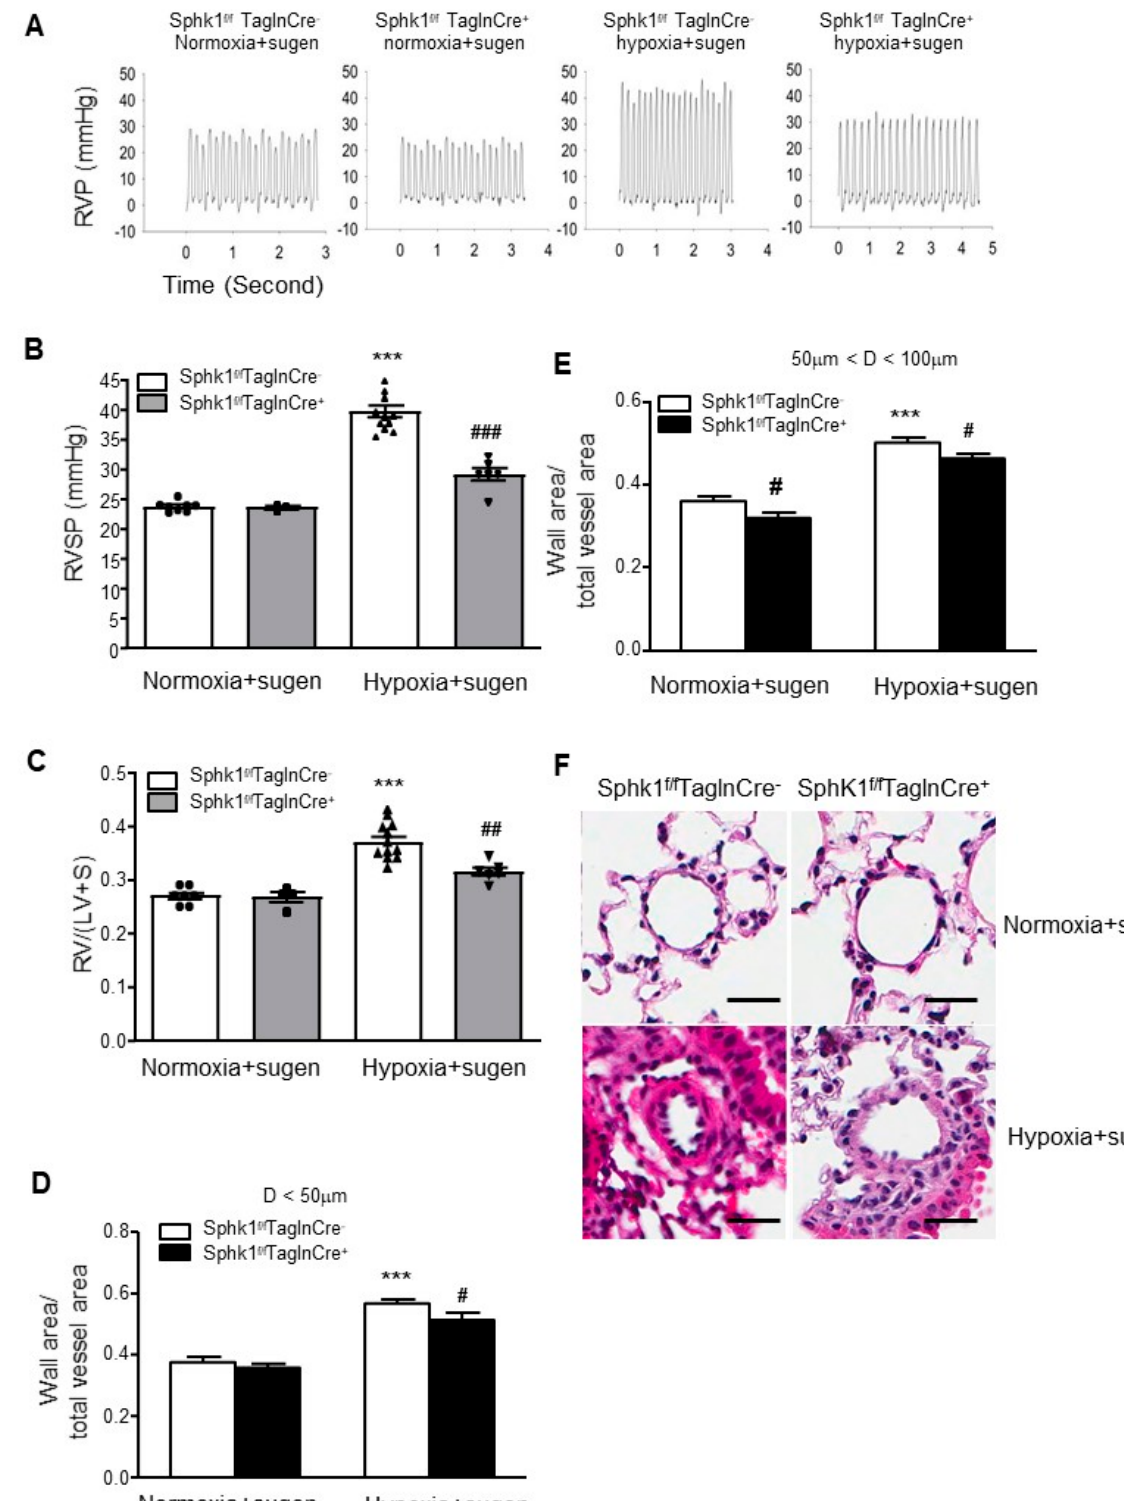
Figure 3. Smooth muscle cell-specific Sphk1 knockout ( Sphk1 f/f TaglnCre + ) mice are protected from hypoxia-plus-Sugen-induced pulmonary hypertension. Four doses of Sugen (20 mg/kg body weight) were given subcutaneously to the mice once per week. When compared with their wild-type siblings ( Sphk1 f/f TaglnCre − ), Sphk1 f/f TaglnCre + mice exposed to hypoxia plus Sugen developed ( A , B ) less severe elevations in right ventricular systolic pressure (RVSP), ( C ) less right ventricular